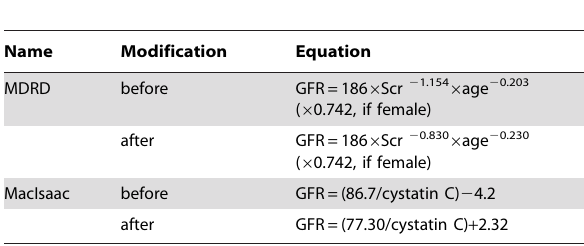
Table 1. Equations before and after modification by mathematical algorithms.